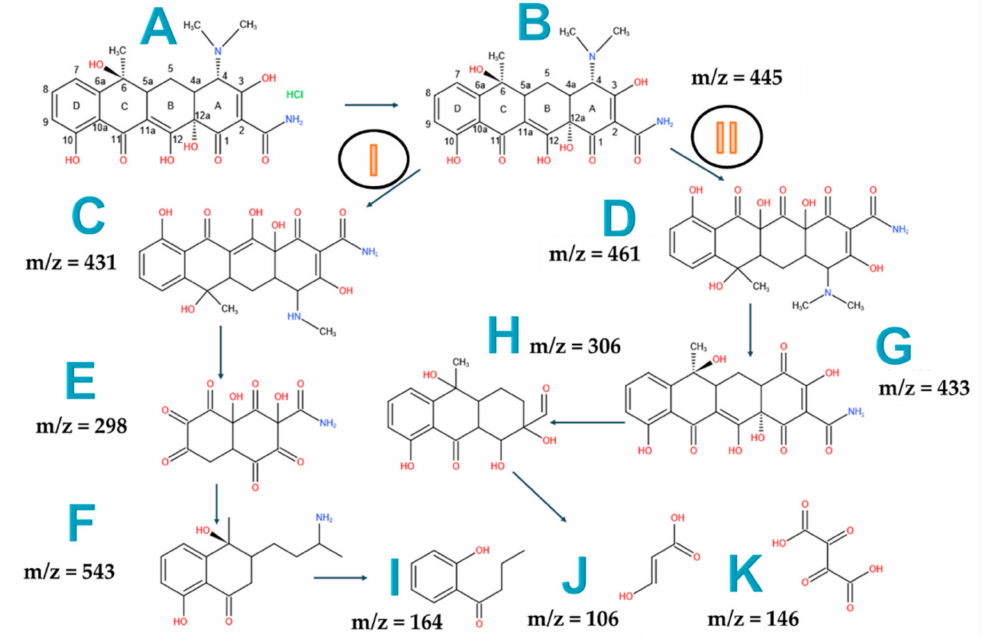
Figure 5. The proposed photodecomposition pathways of TC over F-BFTOC. ( A – K ) are tetracycline and different degradation products,